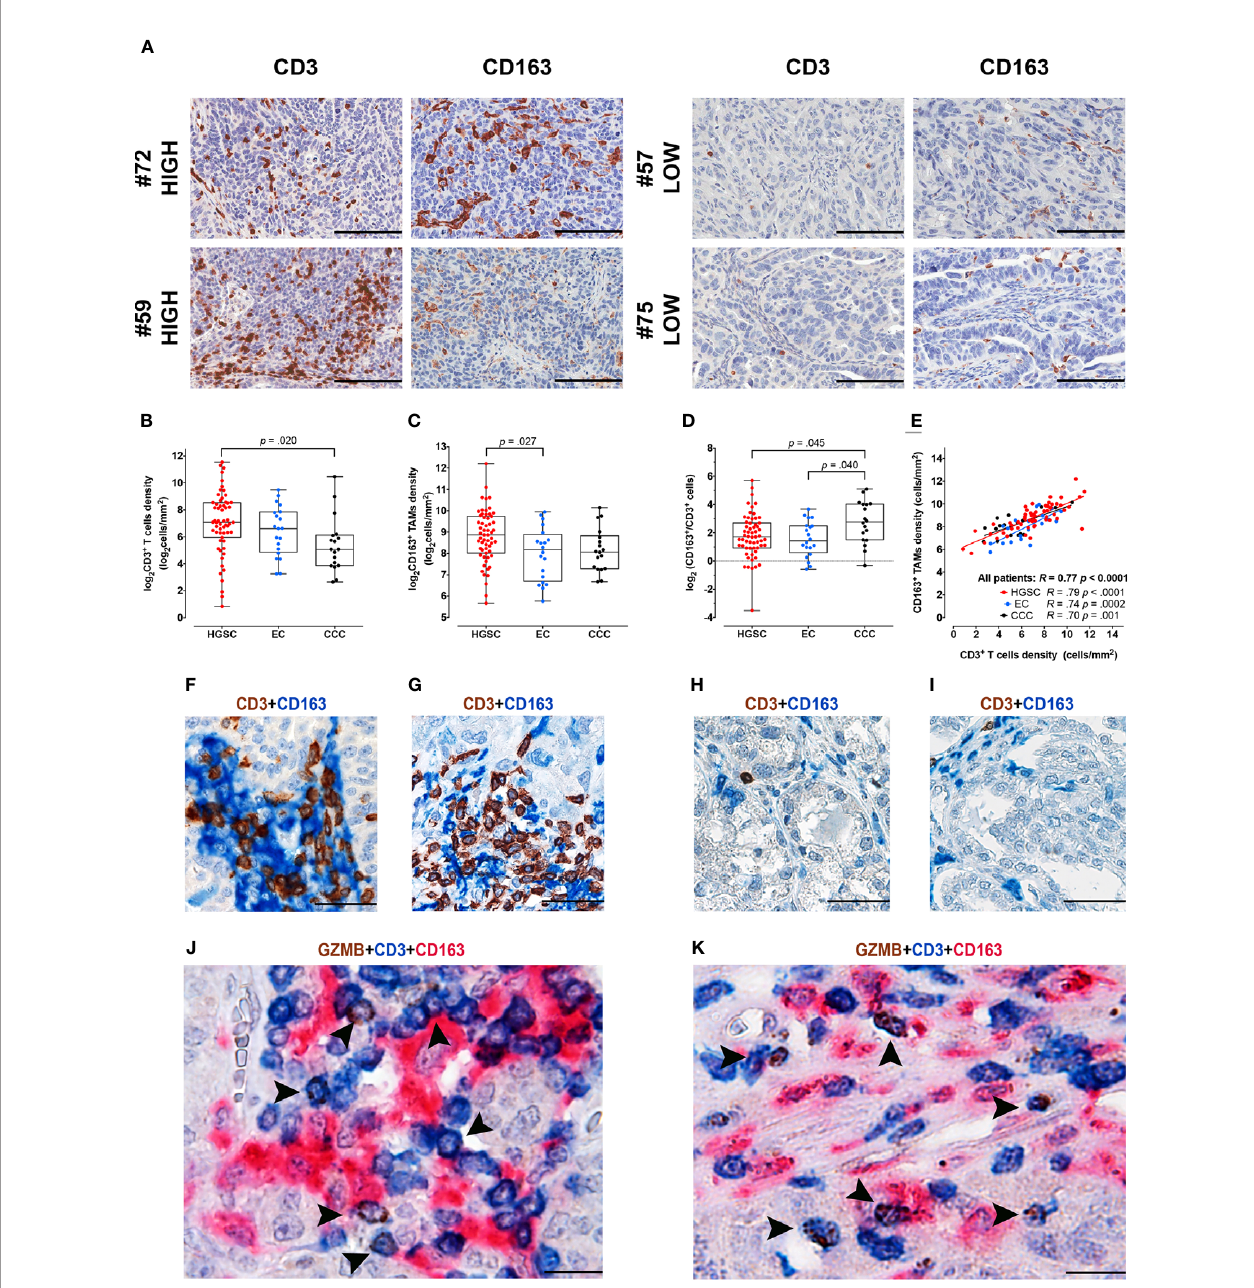
FIGURE 1 | Immune contexture in OCs by digital microscopy and interactions of CD3 + T-cells and CD163 + TAMs. (A) Sections are from four representative HGSCs (case #72, #59, #57 and #75) and immunostained for CD3 and CD163, recognizing T-cells (left column) and tumor-associated macrophages (TAMs) (right column). Case #72 and #59 are HGSCs with rich immune cell density, characterized by high CD3 + T-cells and CD163 + TAMs, intraepithelial and stromal in fi ltrates. In opposition case #57 and #75 correspond to two HGSCs with low immune cell density, showing very low-number of CD3 + T-cells and CD163 + TAMs. Sections are counterstained with hematoxylin. Images had been acquired form Digitalized slides using Aperio Image Scope (Leica Biosystems) Magni fi cation 200×; scale bar 100 um. Box plots showing CD3 + T-cells (B) and CD163 + TAMs (C) densities in different OCs subtypes. Box-plots showing the ratio of CD163 + /CD3 + densities (D) . Scatter plot (E) illustrating the correlation analysis between CD163 + and CD3 + immune cells ’ densities in the whole cohort and among different OCs subtypes. P values estimated by One-way ANOVA with Tukey ’ s correction for multiple comparisons in (B – D) ; R and P values estimated by Pearson correlation test in (E) . Sections from HGSCs (F, G, J, K) and CCCs (H, I) cases and immunostained as labeled, showing common interactions between T-cells and CD163 + TAMs observed in HGSCs and not in CCCs; magni fi cation: 400× (F – I) , 600× (J, K) ; scale bar: 50 um (F – I) ; 33 um (J, K) . HGSC, High Grade Serous Carcinoma; EC, Endometrioid Carcinoma; CCC, Clear Cell